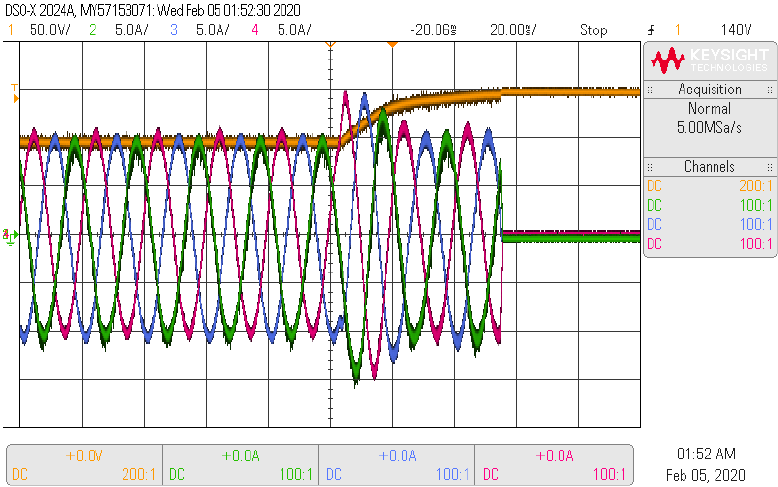
Figure 14. Over-voltage